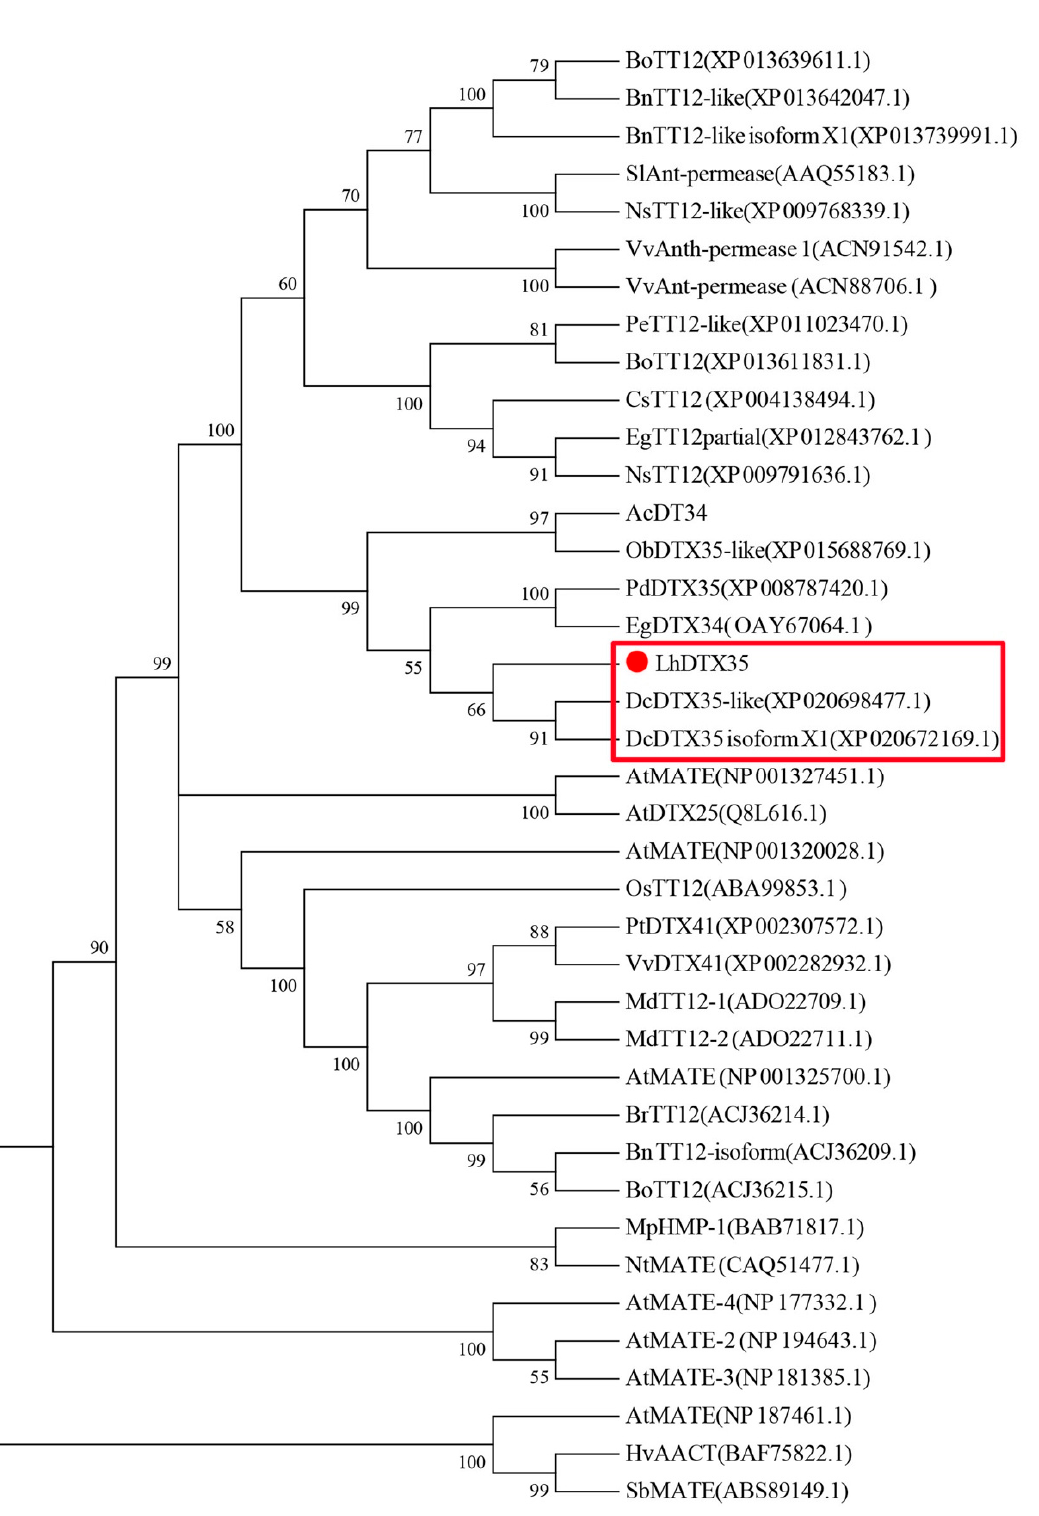
Figure 5. Phylogenetic tree of the predicted amino acid sequences of the Lilium multidrug and toxic compound extrusion (MATE) protein and MATE proteins from other plants. The phylogenetic tree was constructed using MEGA 6.0 software and the NJ method. The red dot indicates the Lilium MATE-like protein identified in this study.